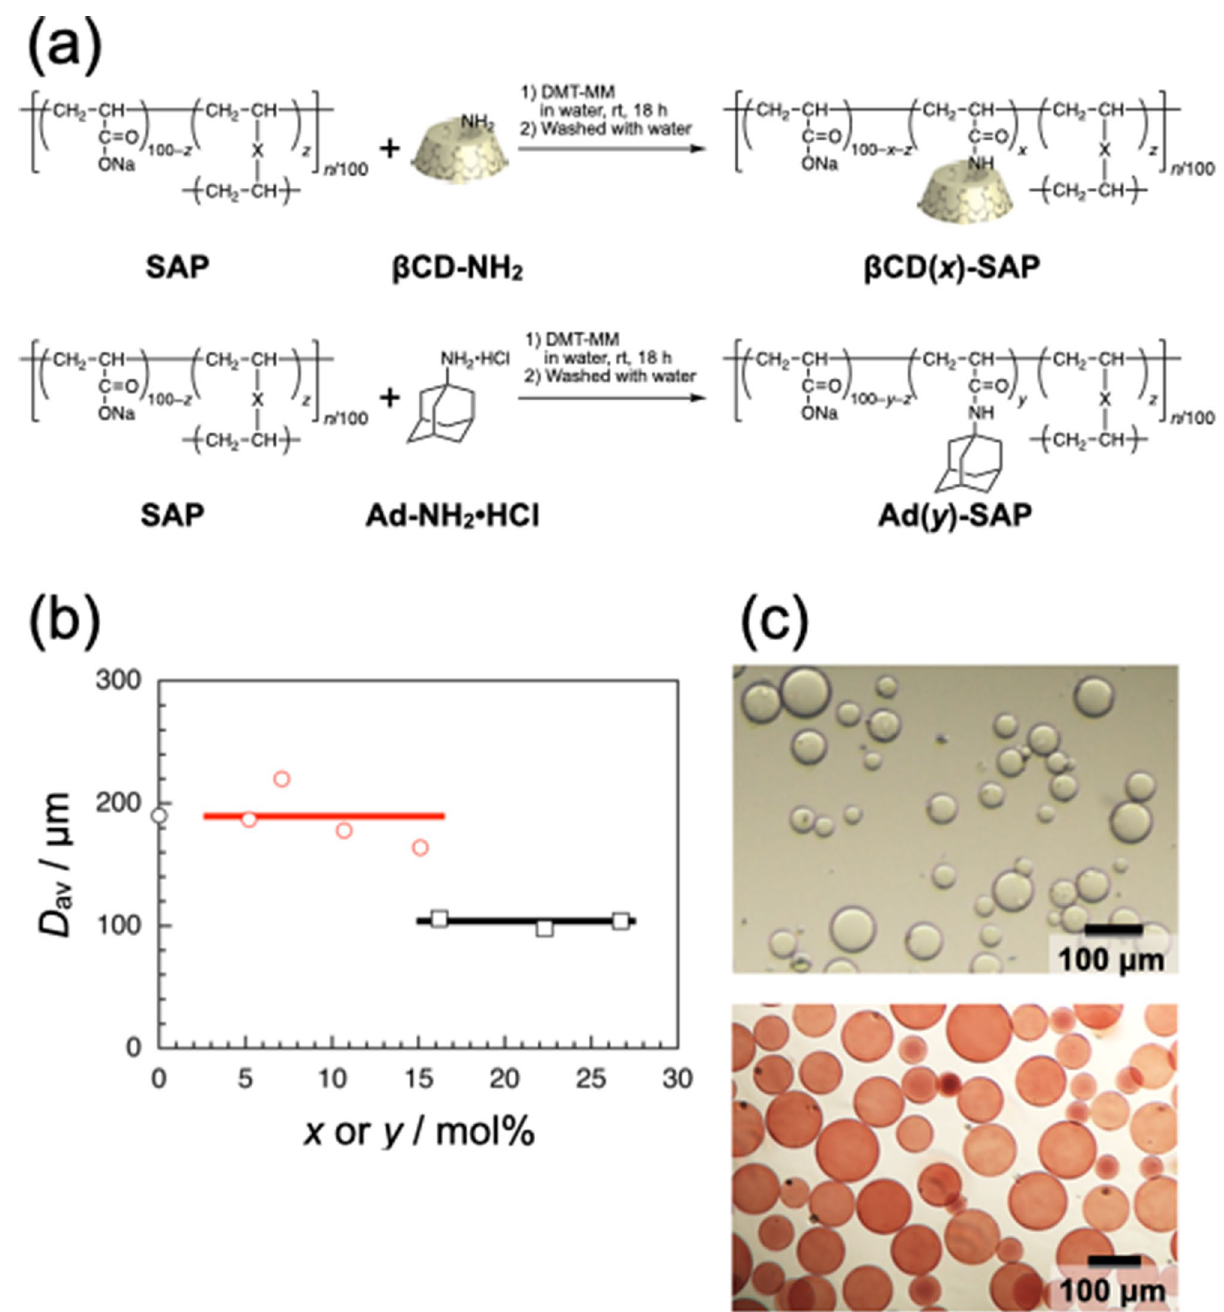
Figure 1. Preparation of βCD( x )-SAP and Ad( y )-SAP microparticles. ( a ) Synthetic scheme of βCD( x )-SAP and Ad( y )-SAP microparticles. ( b ) The average diameter ( D av ) as a function of x or y for the unmodified SAP (black circle), βCD( x )-SAP (black square) and Ad( y )-SAP microparticles (red circle). ( c ) A typical example of optical micrographs for βCD(26.7)-SAP (colorless) and Ad(15.1)-SAP microparticles (red).